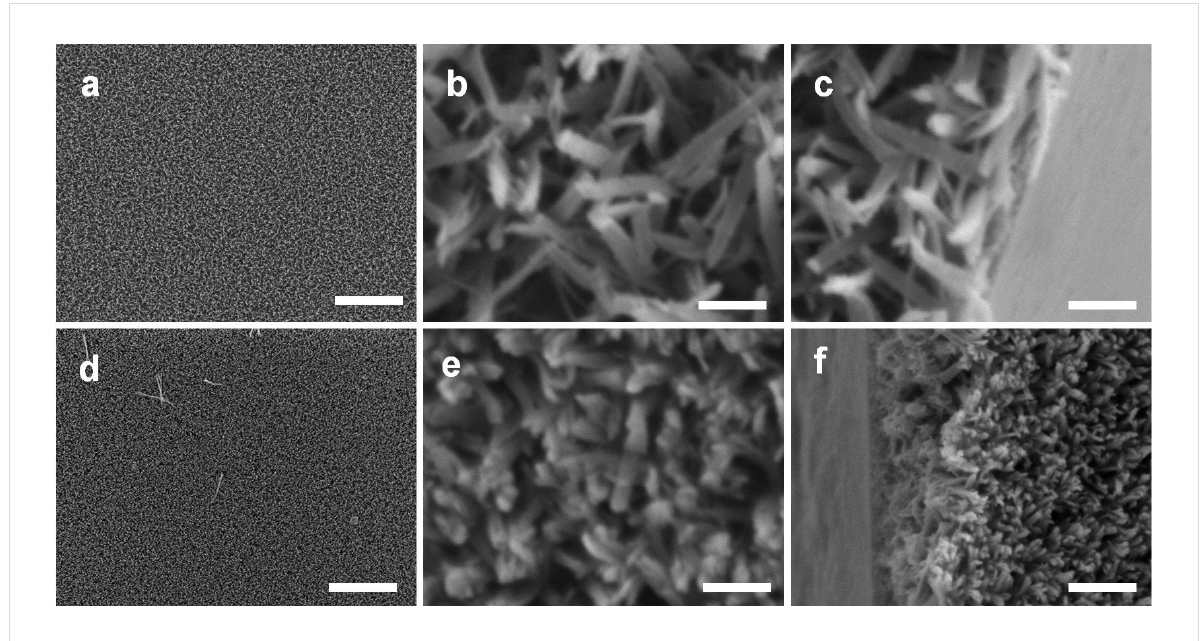
Figure 5: SEM images of LPEI@silica nanograss surface prepared from LPEI concentrations of 3.0 wt % (a, b and c) and 5.0 wt % (d, e and f). The silica-mineralization reactions were performed by using a source mixture of 15 mL water and 0.5 mL MS51 for 40 min at room temperature. The scale bars are 10 μ m (a and d), 400 nm (b, c and e) and 500 nm